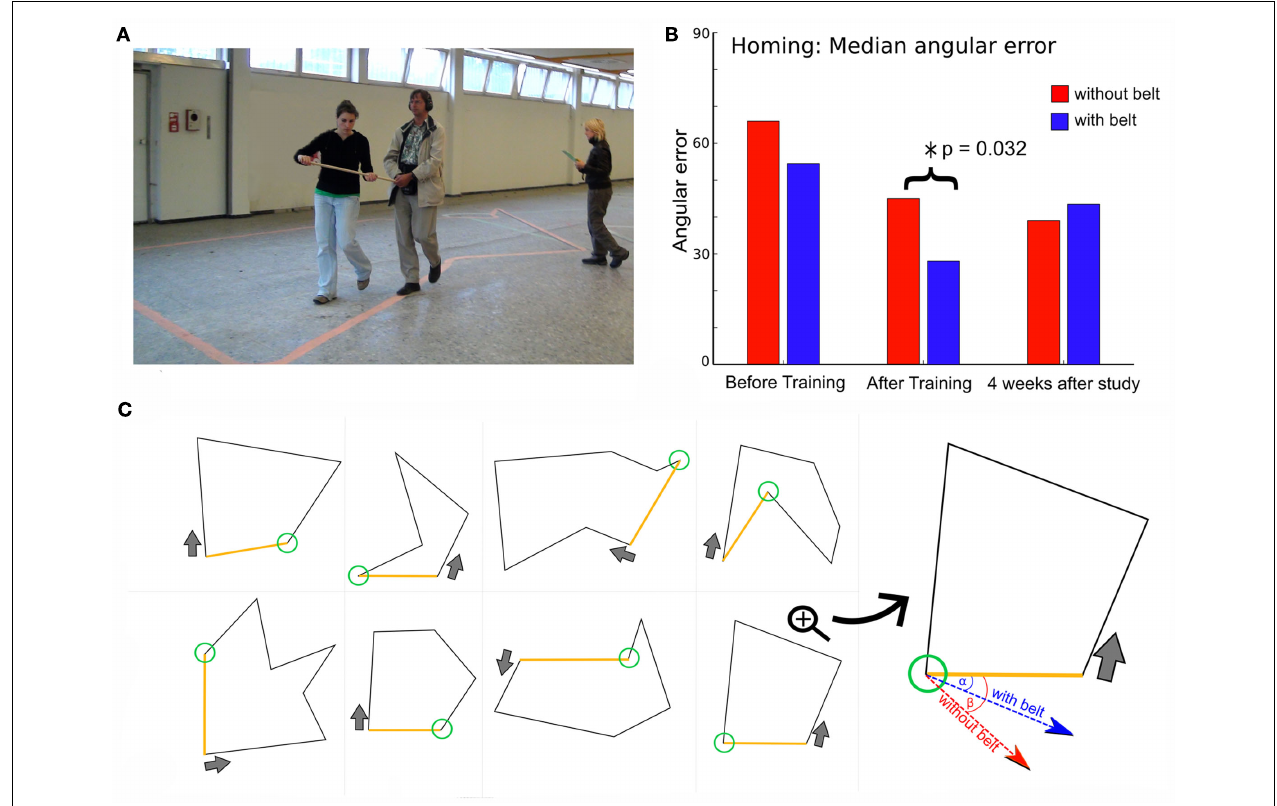
conditions. (C) Overview of the eight different homing polygons.The subject was led along the edges of the figure starting at the gray arrow, which also indicates the direction of the run. At the green circle, the experimenter left the polygon.The subject’s task was to return straight to the starting point.The orange line indicates the optimal path back home. In the right panel, the trajectory of the actual paths chosen by the subject with belt (blue) and without belt (red) is shown with the error angles alpha and beta